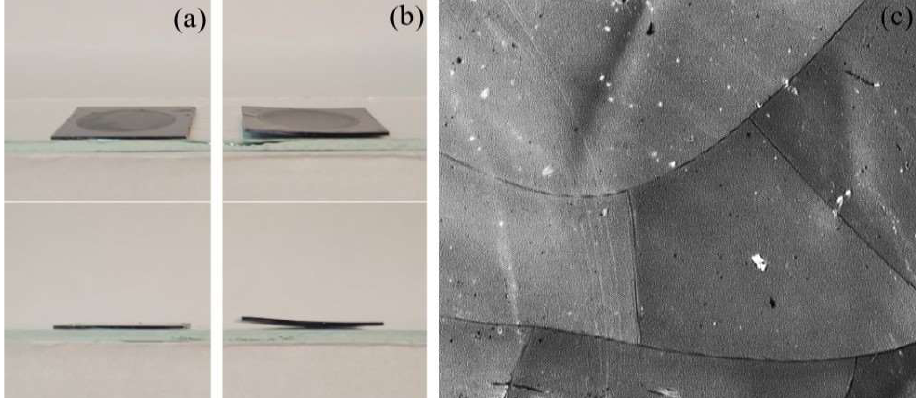
Figure 2. Photographs of 150 μm thick smooth sample ( a ) and 180 μm thick curved sample ( b ), as well as an optical microscope image of cracks on the surface of a 200 μm thick porous layer ( c ) after the impact of high temperatures (950 °C) and pressure drops (1–50 kPa) during GLC synthesis.